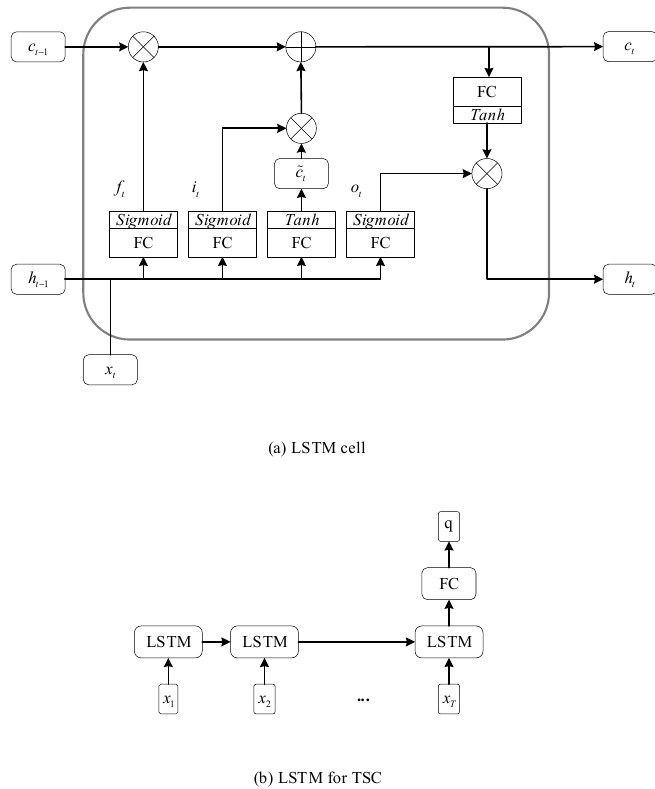
Figure 2. The schematic of the Long Short Term Memory (LSTM) for TSC.